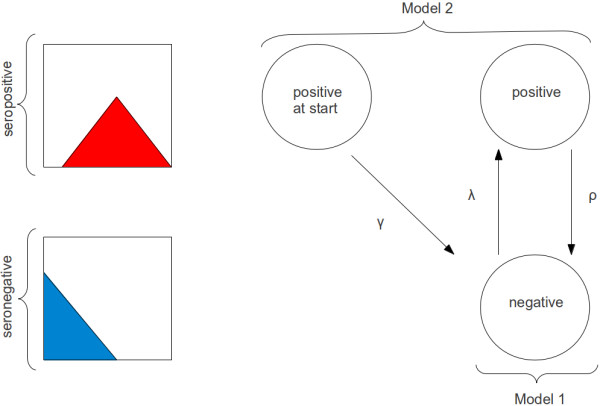
Models for the transitions between serological states. Two models for the transition of individuals from positive (top row) to negative (bottom row) serological states over the course of the study: Model 1 assumes one positive and one negative state, with conversion rate λ and reversion rate ρ. Model 2 treats individuals separately which are already seropositive at the start of the study. Those revert at a rate γ, which may be different from ρ. Titre distributions in positive and negative individuals are schematically indicated on the left.